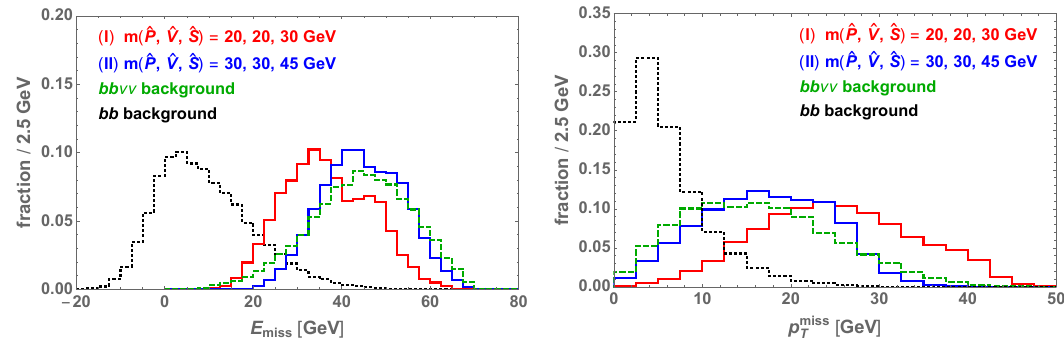
Figure 9 . Normalized distributions of the missing energy ( left ) and missing transverse momentum ( right ) for the Z ! ^ P ^ S ! b (cid:22) b(cid:23)(cid:23) + X signal, the irreducible b (cid:22) b(cid:23)(cid:23) background and the reducible b (cid:22) b background at a Z factory, after the basic selection requiring 2 b